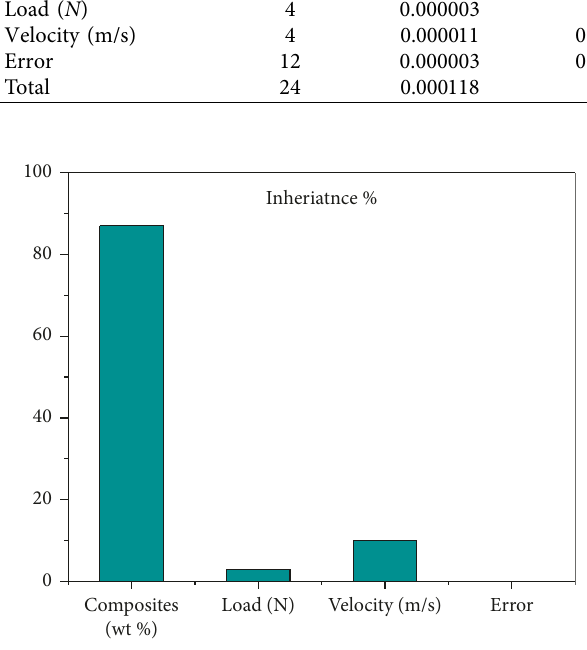
Figure 7: Inheritance % of processing parameters.